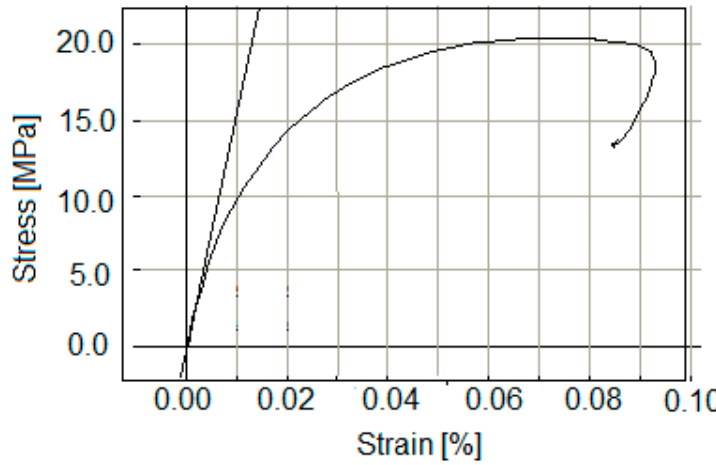
Figure 7. Diagram stress-strain for traction test, pipe Ф 90 × 6.